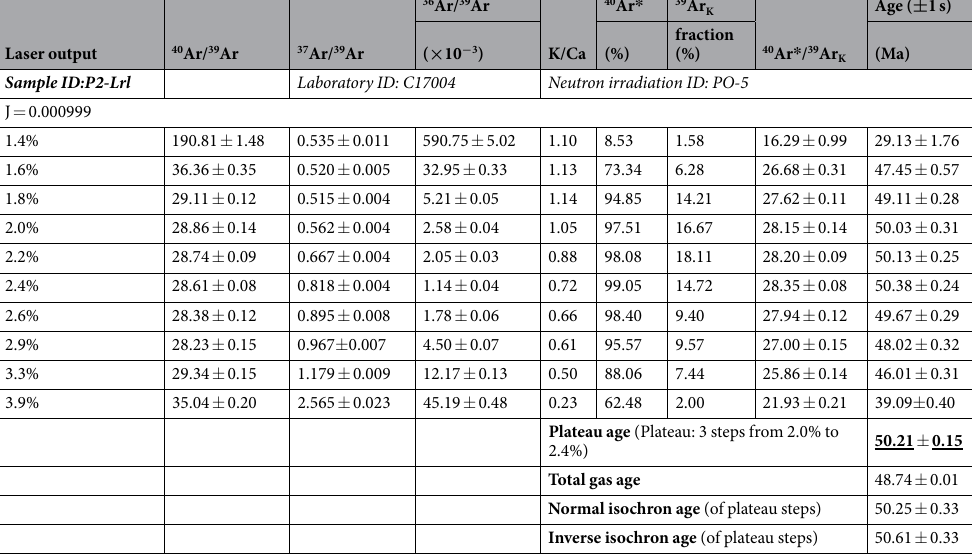
Table 2. 40 Ar/ 39 Ar analytical result of basaltic lava flow, P2-Lrl. # 100% corresponds to 50 W output of CO 2 laser. All the errors indicate 1 sigma error. 40 Ar * : radiogenic 40